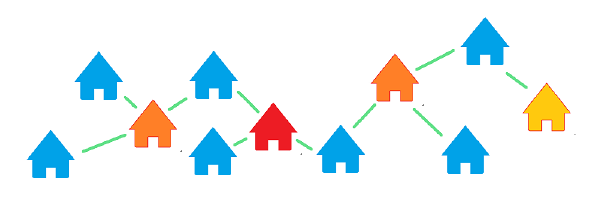
Figure 9. First and second-order subject pairs for a subject property in red.